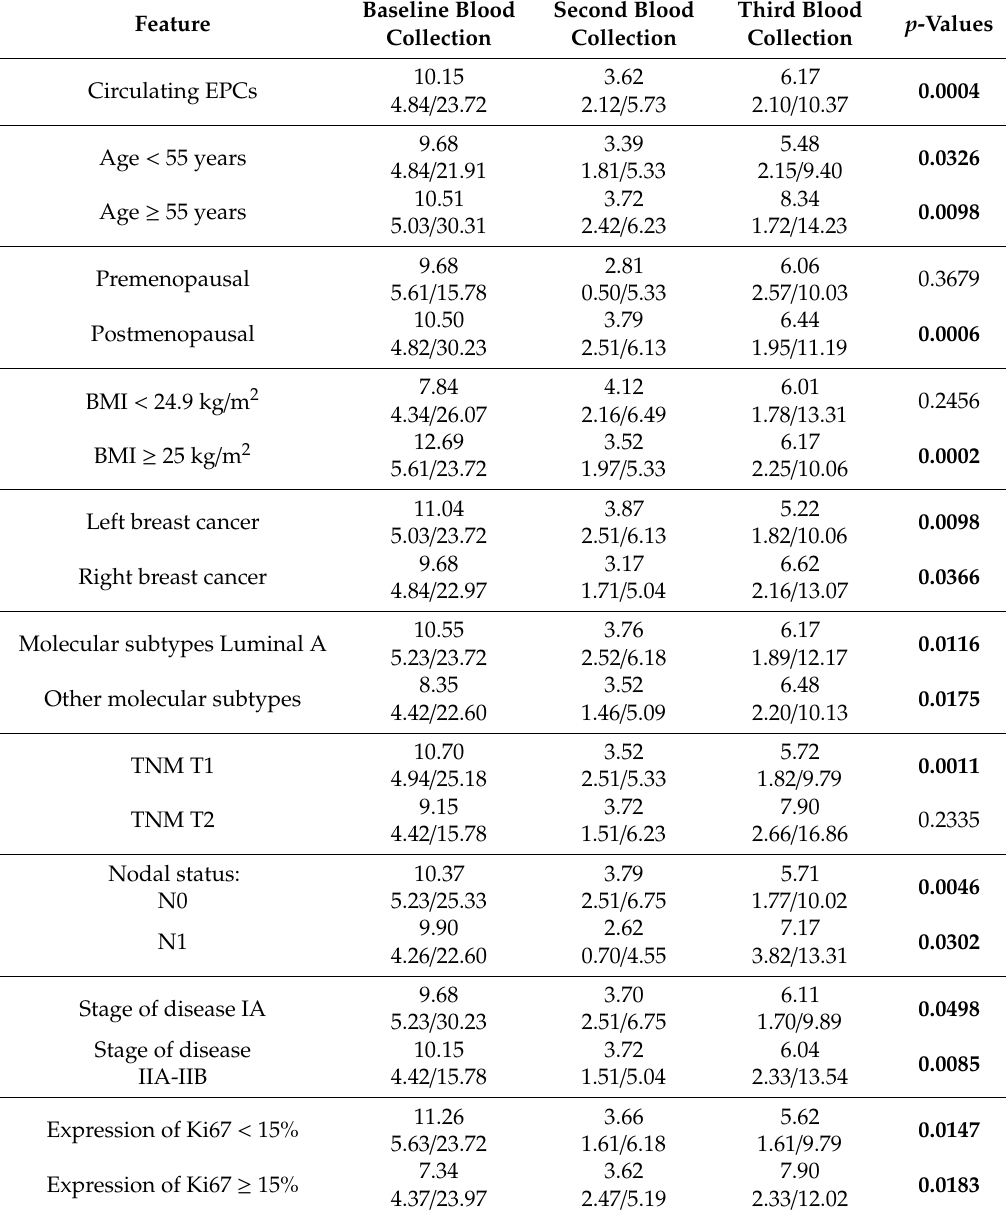
Table 1. The impact of adjuvant treatment on the number of circulating EPCs. Baseline Feature